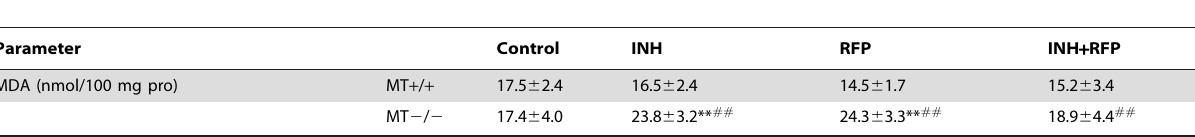
Table 2. Lipid peroxidation in livers of wild-type (MT + / + ) and MT 2 / 2 mice treated with INH and RFP.